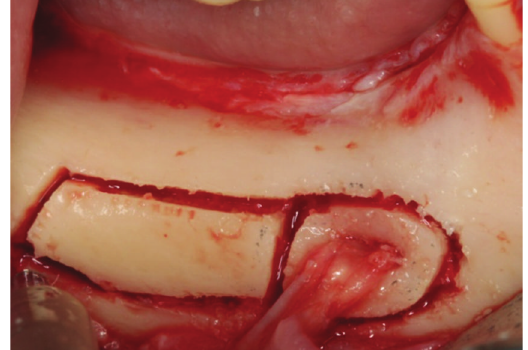
Figure 4: Osteotomy lateral to the mandibular canal involving the mental foramen.